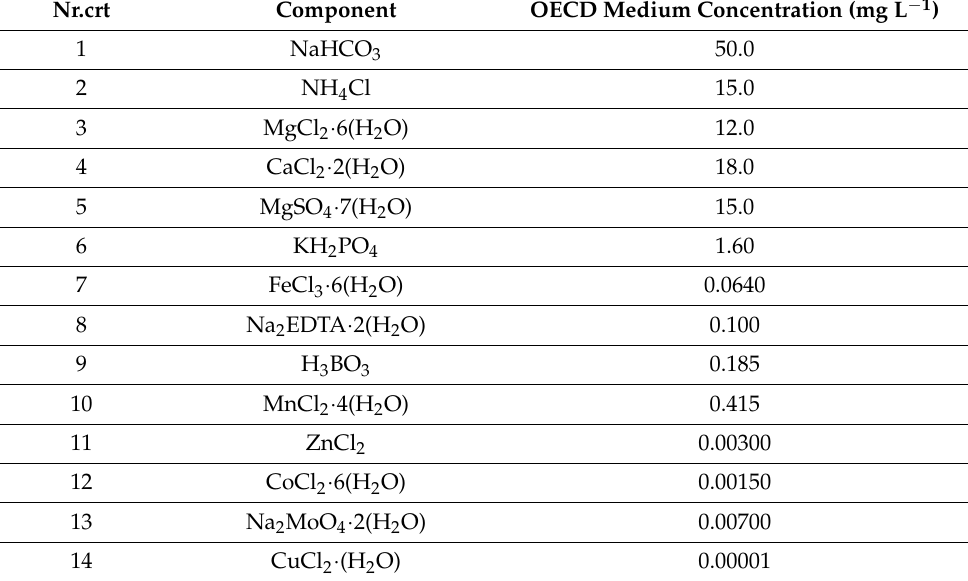
Table 1. Composition of the Organisation for Economic Cooperation and Development (OECD) Test no. 201 medium